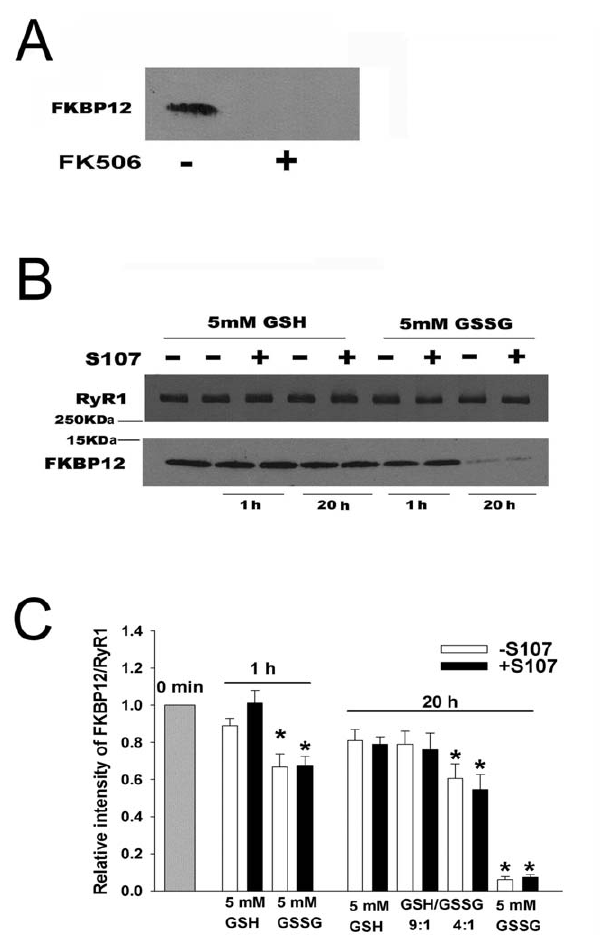
Figure 2. Effects of FK506 and S107 on FKBP12 dissociation from SR vesicles in the presence of GSH and GSSG. (A) Representative immunoblot of SR vesicles not treated and treated with FK506. SR vesicles were incubated with 10 m M FK506 as described in Materials and Methods, followed by centrifugation to remove FK506 and dissociated FKBP12. (B and C) FKBP12 dissociation from SR vesicles in the presence of GSH and GSSG. Immunoblots of SR vesicles not treated with FK506 were incubated for 1 and 20 h at 24 u C in 0.25 M KCl, 20 mM imidazole, pH 7.0, 50 m M free Ca 2 + , protease inhibitors, and the indicated concentrations and ratios (5 mM total glutathione) of GSH and GSSG in the absence and presence of 44 m M S107. Free FKBP12 was removed by centrifugation. Data were normalized to SR vesicles not incubated (gray bar, 0 min) and are the mean 6 SEM of 4–5 experiments. *p , 0.05 compared to SR vesicles at 0 min not treated with S107.